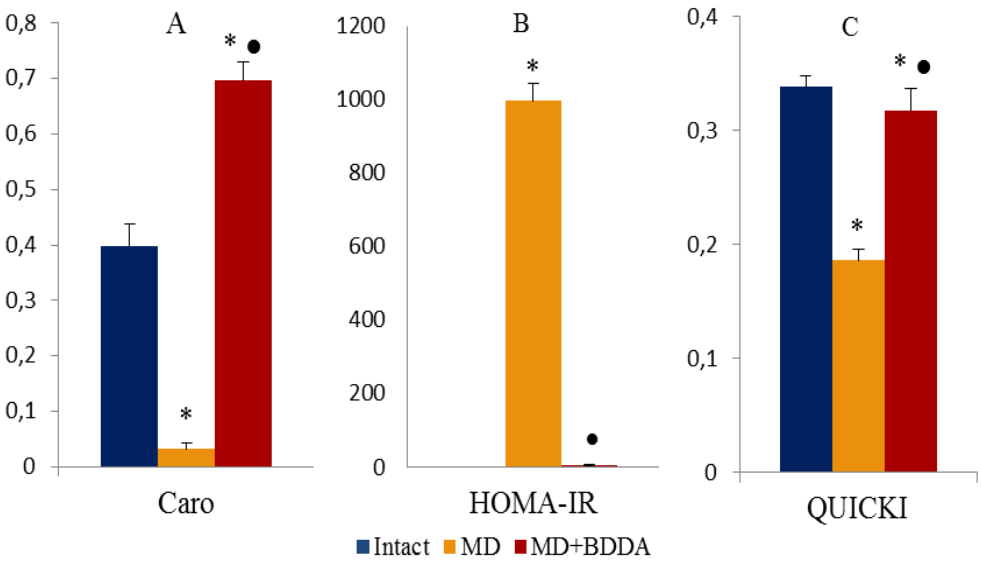
Figure 3. Caro ( A ) indices and HOMA-IR ( B ), QUICKI ( C ), UE were measured at d70. The Caro index and Homeostasis Model Assessment of Insulin Resistance (HOMA-IR) were estimated using the following formulas: Caro = GN/IN and HOMA−IR= (IN × IG)/22.5, where IN-insulin is fasting, IU/ml; GN—fasting glucose, Mmol/L. Groups: intact—a control group from intact mice, MD—mice with MD, MD+BDDA—mice with MD treated BDDA. *: significance of difference compared with controls ( p < 0.05); ●: significance of difference compared with the MD group ( p < 0.05).